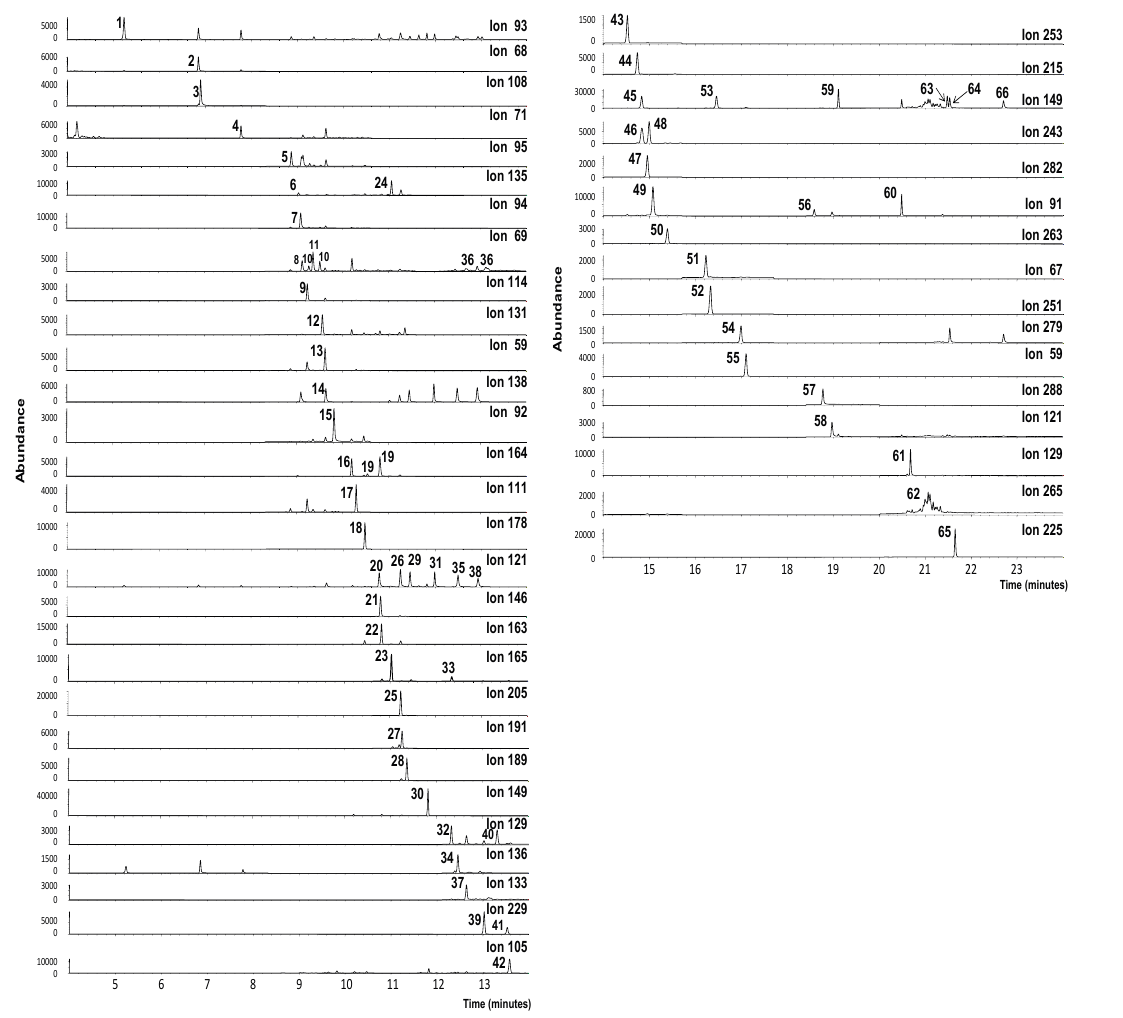
Figure 2. Selected ion monitoring (SIM) chromatogram of a standard mixture of the target compounds (200 ng·mL − 1 ; di-iso-heptyl-phthalate (DIHP), 400 ng·mL − 1